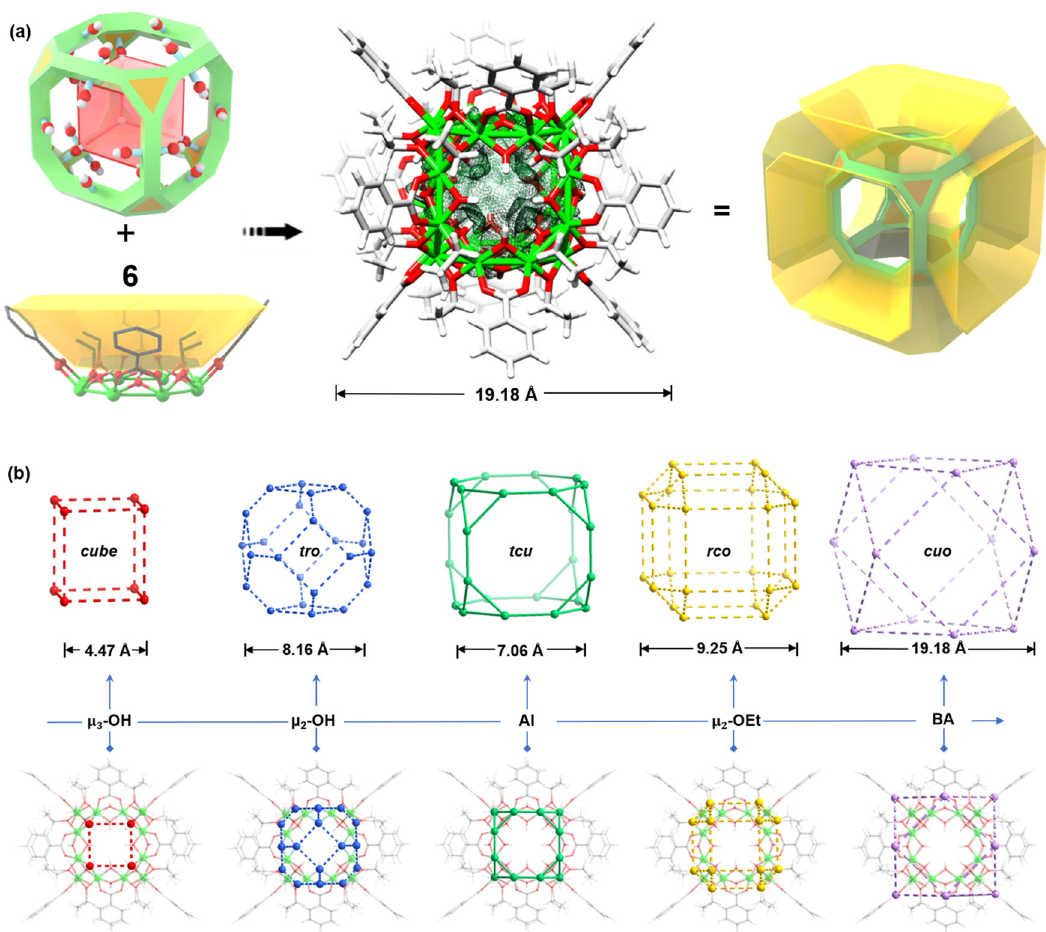
Fig. 2 | The molecular structure of the Al 24 Archimedean cage. a Illustration of the assembly and structural model of the inner inorganic tcu core and calixarene- like organic subunits (atom color code: Al: bright green; O: red; C: gray; H: white). Thesizeofthe tcu cageisca.1.9nmbasedonthedistancebetweentheBAligands. b QuintuplestructuralsymmetricanatomyoftheAl 24 Archimedeansolid.Theinner